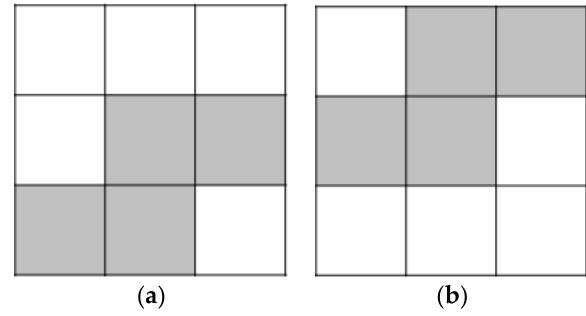
Figure 5. Block texture template angle change. ( a ) 0°; ( b ) 180°.